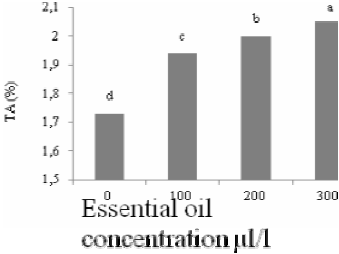
Fig. 1. The effect of basil essential oil treatment on TSS of ‘Golden Drop’ plums